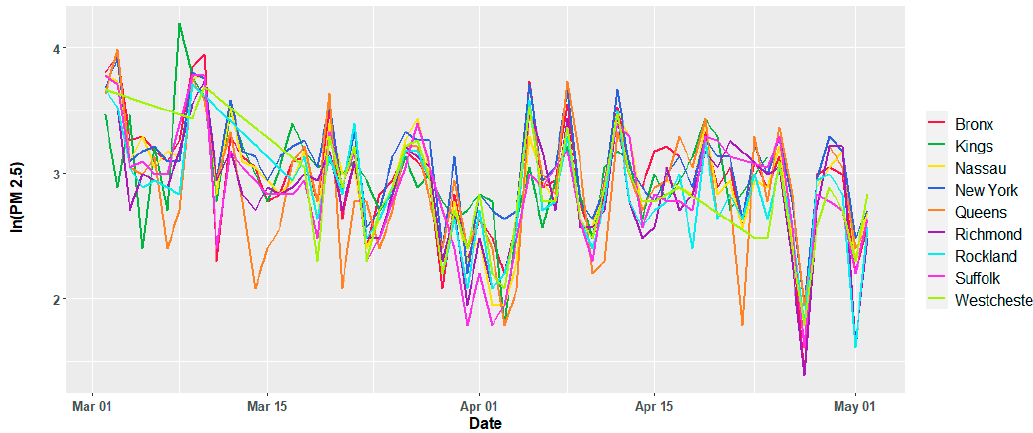
Figure 4. Variation of the daily average concentration of particulate matter PM 2.5 (in µ g / m 3 ) in the natural logarithmic scale for individual counties.